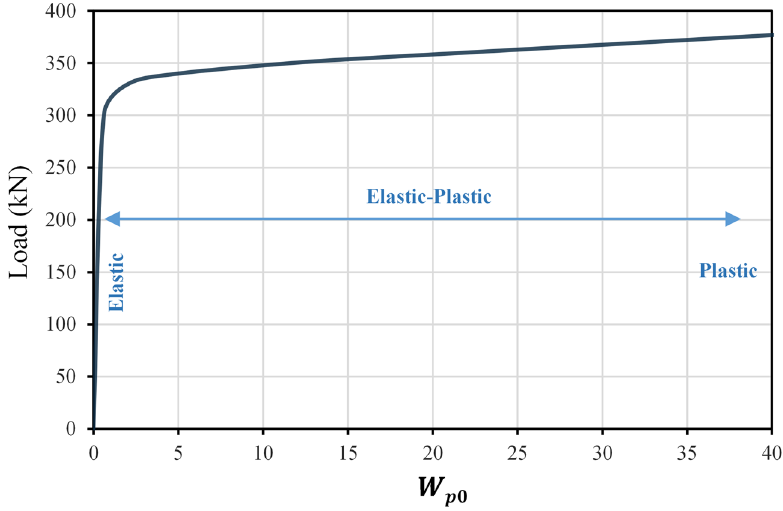
Figure 14. Load-complementary strain energy